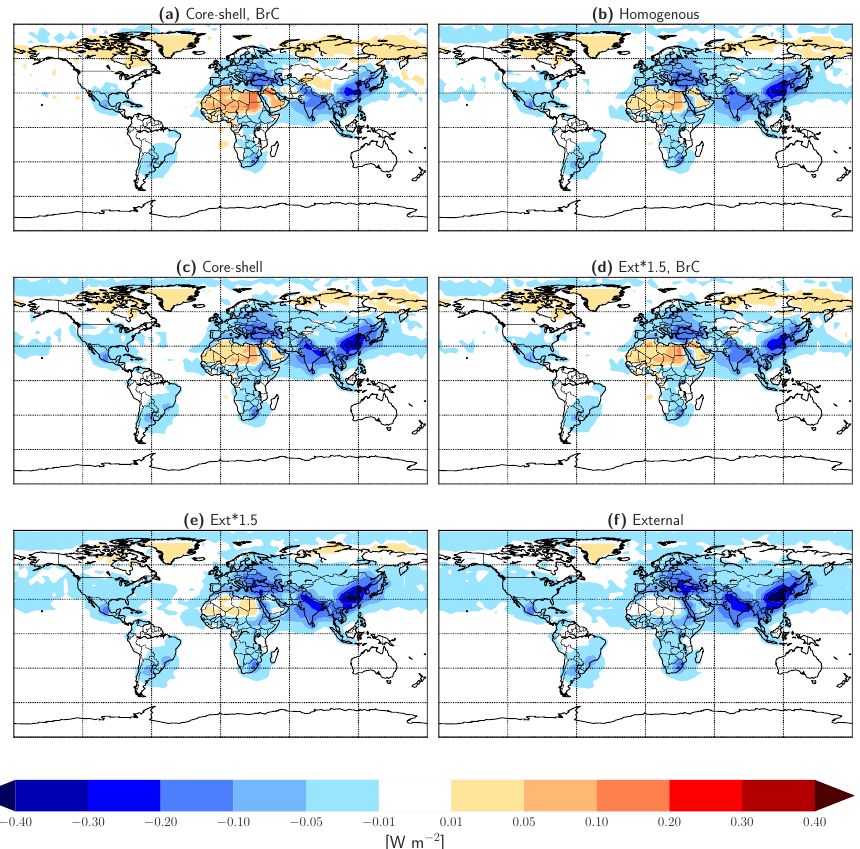
Figure 7. The all-sky direct radiative effect for domestic-waste combustion (BASE-WASTE_OFF) assuming a (a) core–shell with brown carbon, (b) homogenous internal, (c) core–shell, (d) external with brown carbon and an absorption enhancement factor of 1.5, (e) external with an absorption enhancement factor of 1.5, and (f) external mixing state.